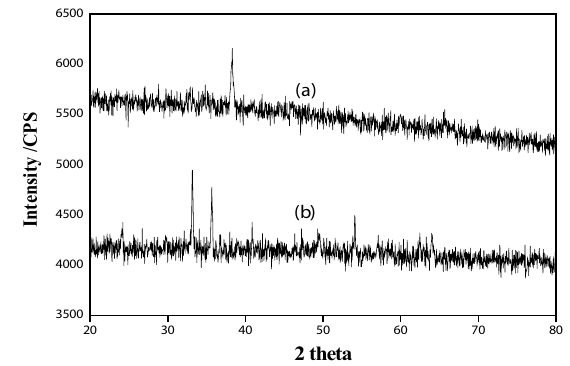
O nano-powder and (b) micro-powder 2 3